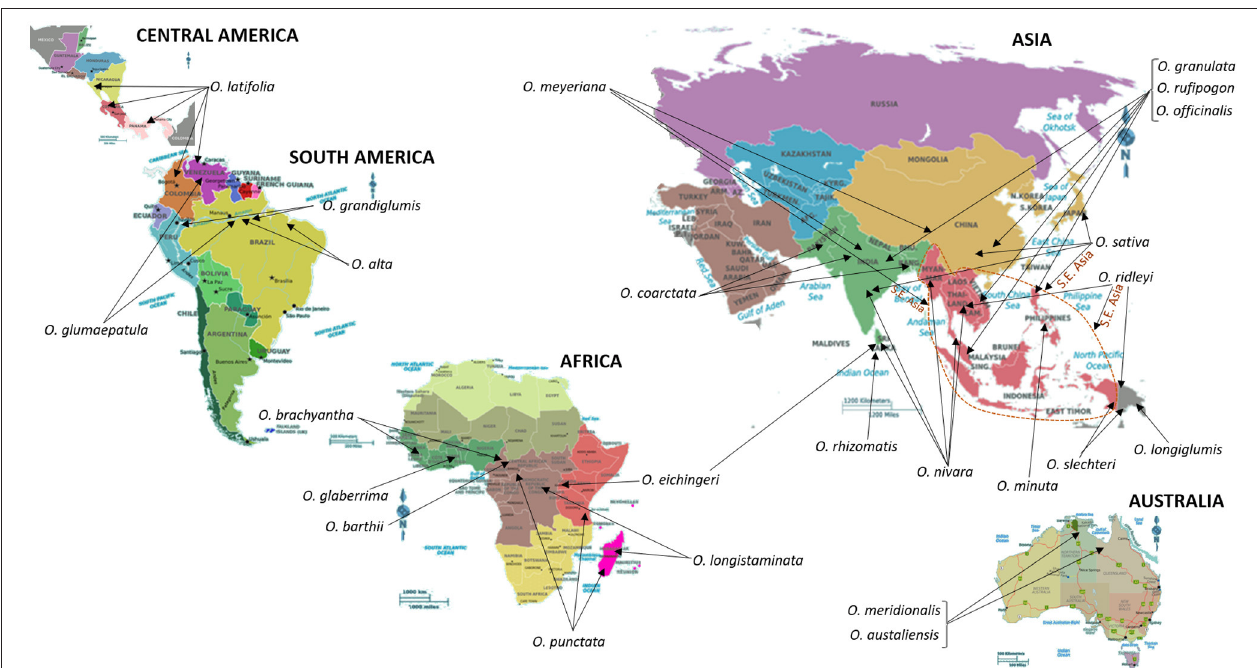
FIGURE 2 | Centers of origin and/or primary sites of diversity and distribution of wild relatives of Rice. South East Asia (S.E. Asia), a key region for the origin and distribution of several wild relatives of Rice, is indicated by a dotted line. Information on the distribution and centers of origin was gathered from Shakiba and Eizenga (2014), and references therein. “The International Rice Genebank, maintained by International Rice Research Institute, holds more than 124,000 rice accessions that include modern and traditional varieties and wild relatives of rice. It is the biggest collection of rice genetic diversity in the world. Countries from all over the world have sent their rice samples to IRRI for safe keeping as well as for sharing” (http://irri.org/). In addition to IRRI, the Germplasm Resources Information Network in Beltsville, USA (https://npgsweb.ars-grin.gov/gringlobal/search.aspx) also stores and distributes genetic material of cultivated rice and its wild